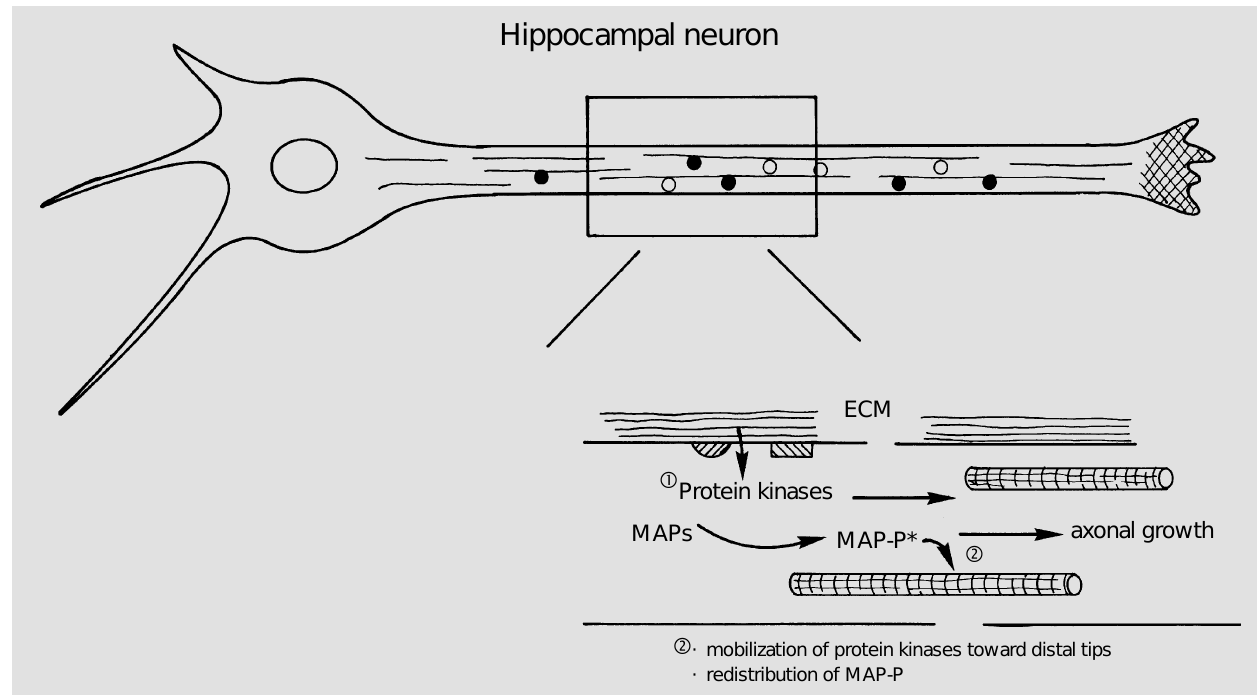
Figure 2 - Schematic representation of a hippocampal neuron, and the effects of the extracellular matrix (ECM) in stimulating axonal extension in growing neurons. The scheme indicates that ECM effects (laminin, others) can be transduced in a sequence of molecular events (1 and 2) leading to phosphorylation of neuronal MAPs and incorporation of MAP-P (phosphorylated MAPs) into growing microtubules, and/or activation and redistribution of protein kinases that could be critical for neuronal growth. In the upper part of the figure, closed circles denote differentially phosphorylated MAPs at specific sites, and open circles the normally phosphorylated